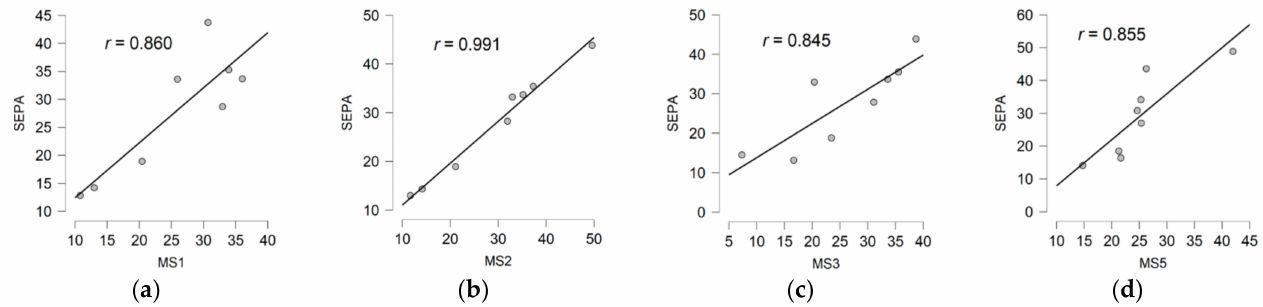
Figure A3. PM2.5 correlation: ( a ) MS1 site reference pump vs. SEPA equivalent instrument ( b ) MS2 site reference pump vs. SEPA equivalent instrument ( c ) MS3 site reference pump vs. SEPA equivalent instrument ( d ) MS5 site reference pump vs. SEPA equivalent